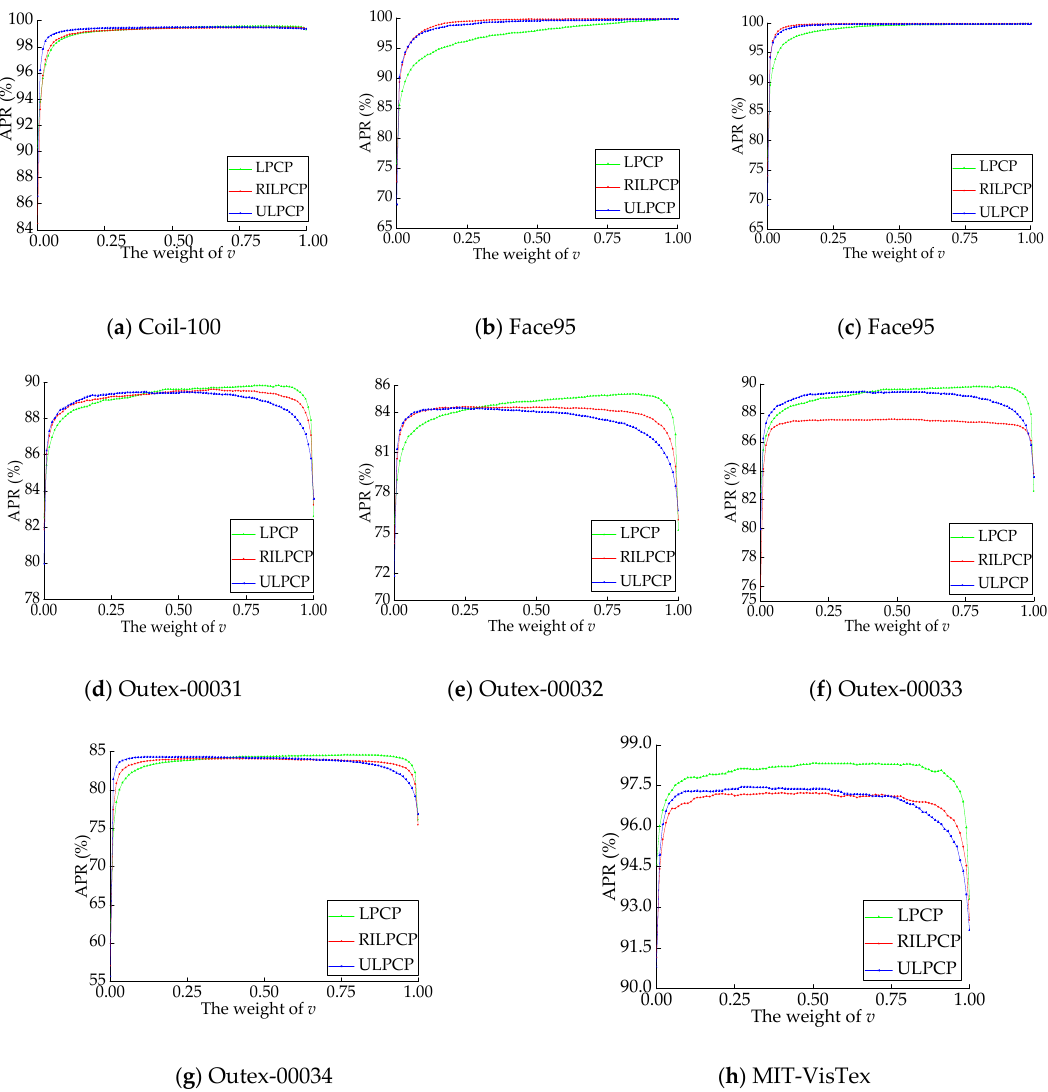
Figure 9. The average precision rate (APR) under the weight value v by using LPCP, RILPCP, and ULPCP on the eight databases.